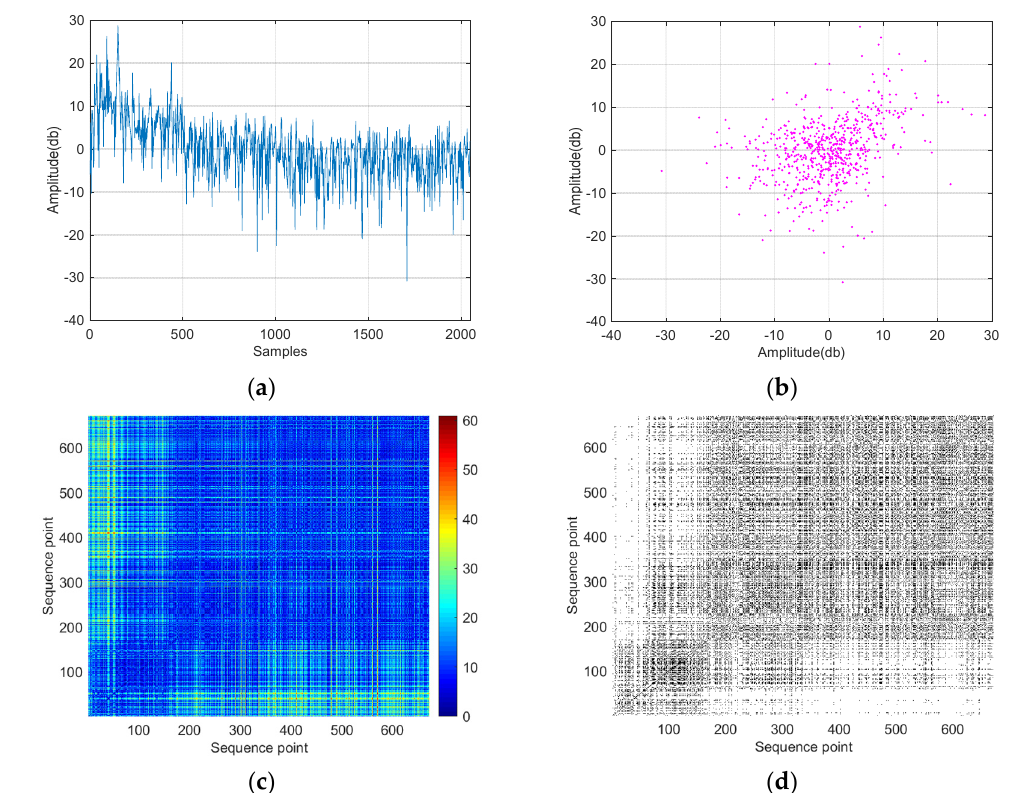
Figure A1. Correlation characteristic map of UCA radar ground clutter data. ( a ) Range time diagram of full-channel pulse splicing data; ( b ) Beam correlation diagram of eight channels of radar; ( c ) The variation diagram of inter pulse correlation coefficient corresponding to ( a ); ( d ) Intra-frame correlation function diagram of C1 beam for channel 1; ( e ) Azimuth cor- relation matrix diagram of C1 beam; ( f ) Azimuth correlation matrix diagram of C2 beam; ( g ) Range autocorrelation of eight channels of the C1 beam; ( h ) Range autocorrelation of eight channels of the C2 beam.